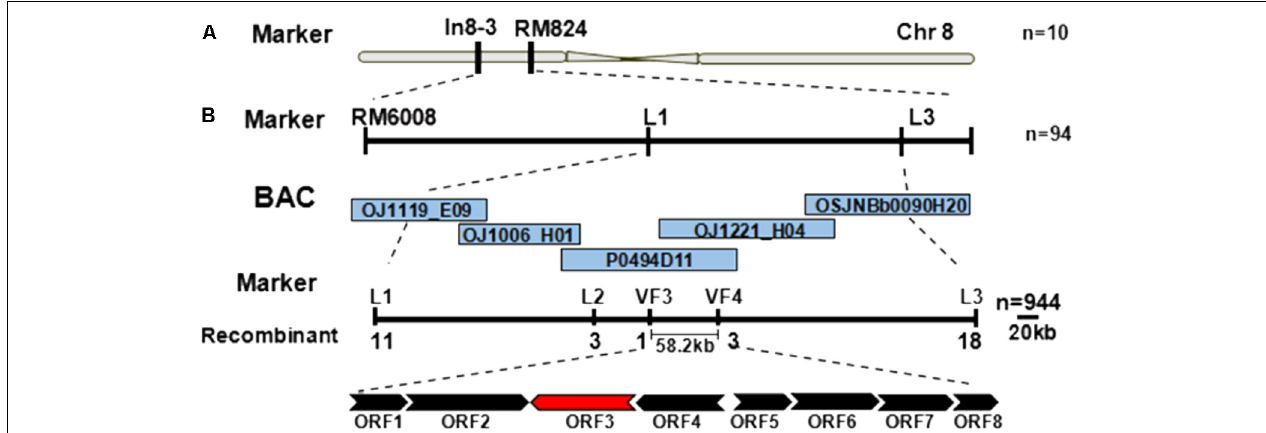
FIGURE 3 | Map-based cloning of the zl16 gene. (A) Rough mapping of the zl16 locus with SSR and In-Del markers. n , the number of zebra leaf-like plants for mapping in the F